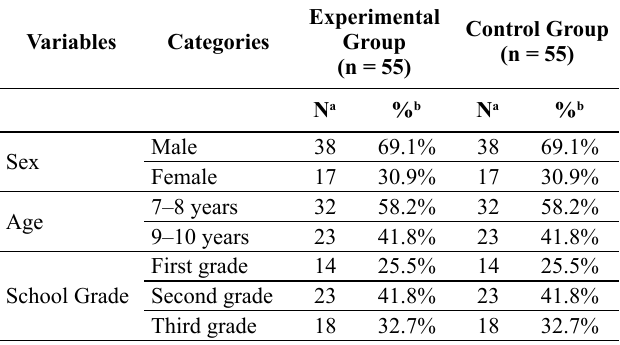
Table 1: Sociodemographic characteristics of the participant sample Variables